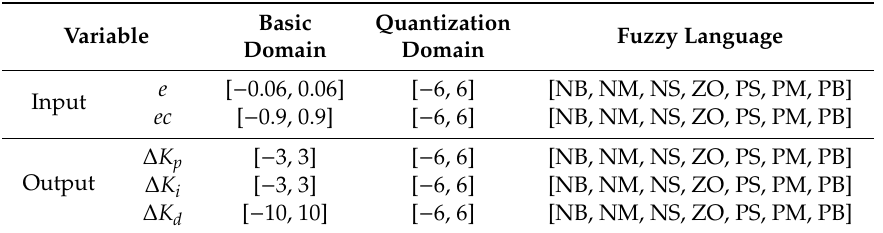
Table 3. Variables and